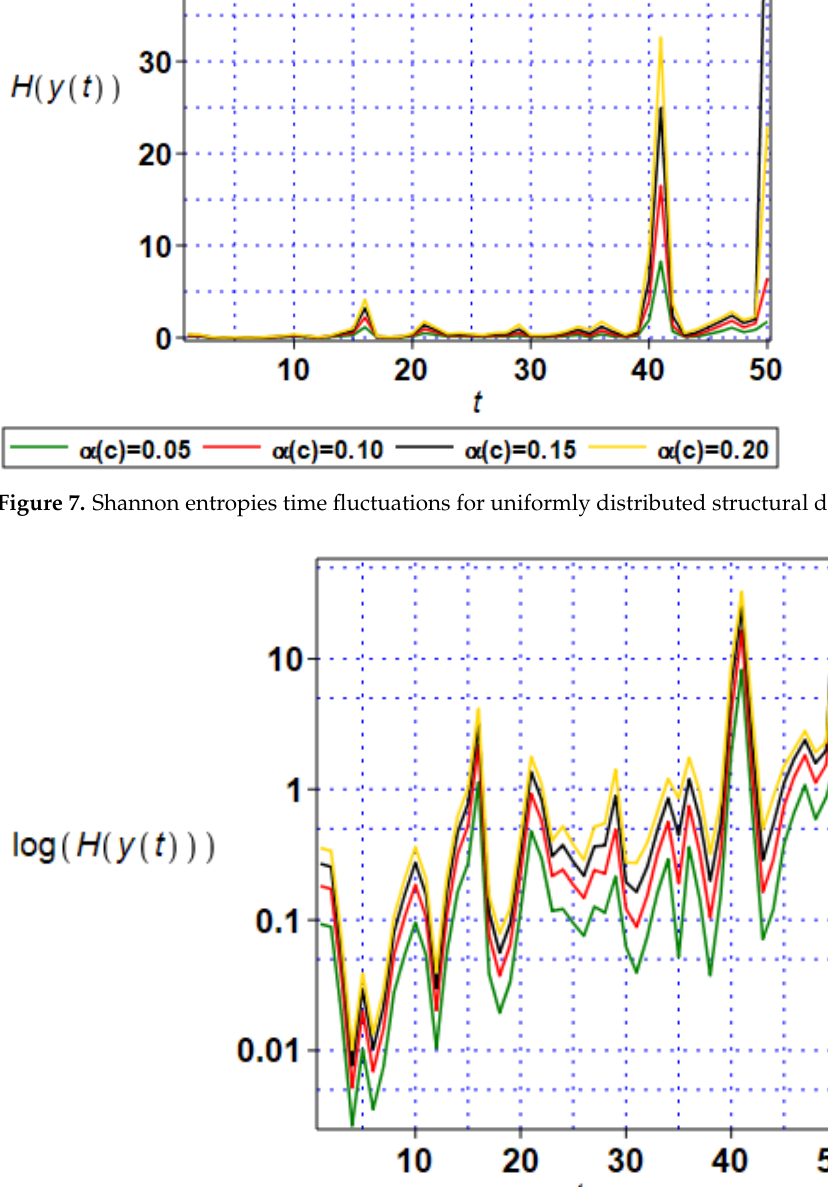
Figure 8. Shannon entropies logarithm time fluctuations for uniformly distributed structural damp- ing.